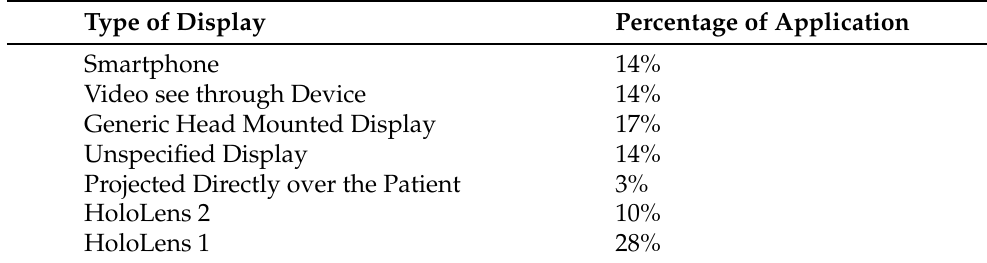
Table 3. Percentage of distribution of the displays of Augmented Reality used in medical applications evaluated in our study.